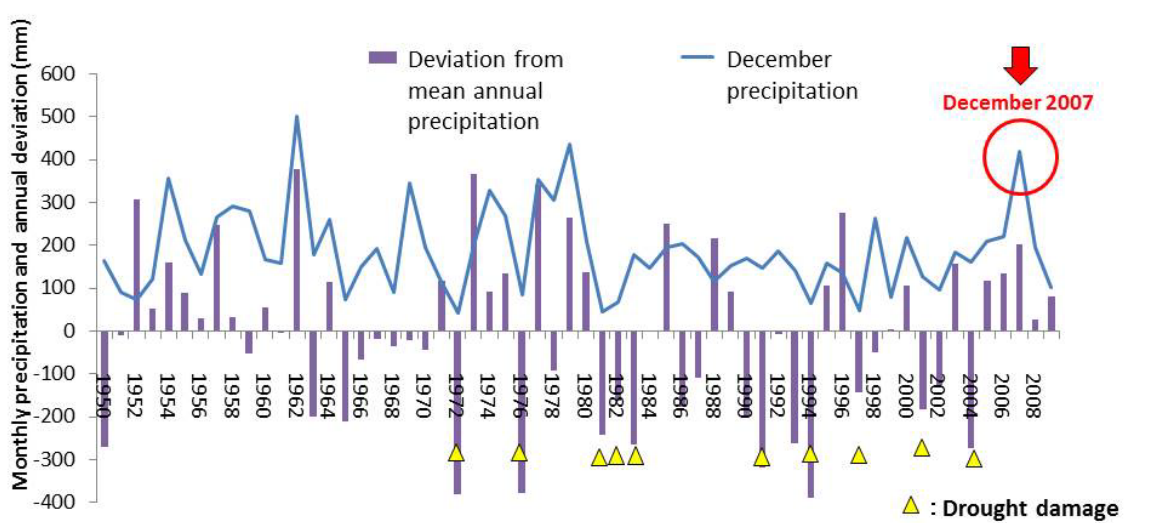
Fig. 2 Rainfall Varievility at Choma of Souyhern Province, Zambia